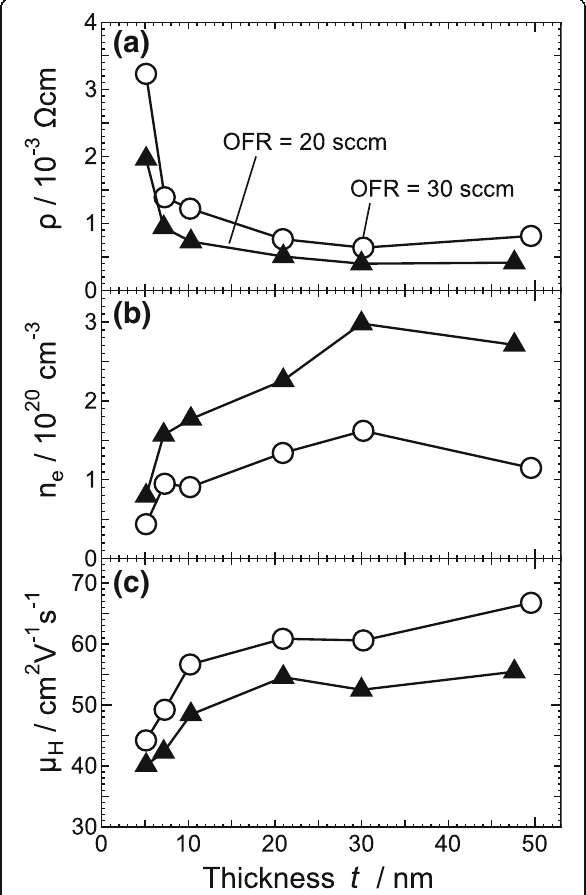
Fig. 4 a Electrical resistivity ρ , b carrier concentration n e , and c Hall mobility μ H of a -ITO films grown at an OFR of 20 sccm (triangles) or 30 sccm (circles) as functions of thickness t . All values were obtained at room